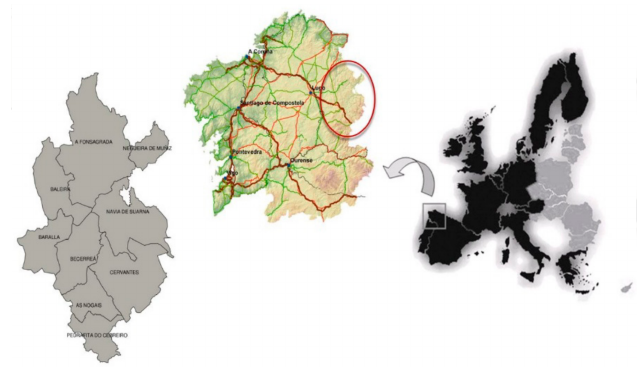
Figure 1. Location of the Fonsagrada-Ancares forest district.